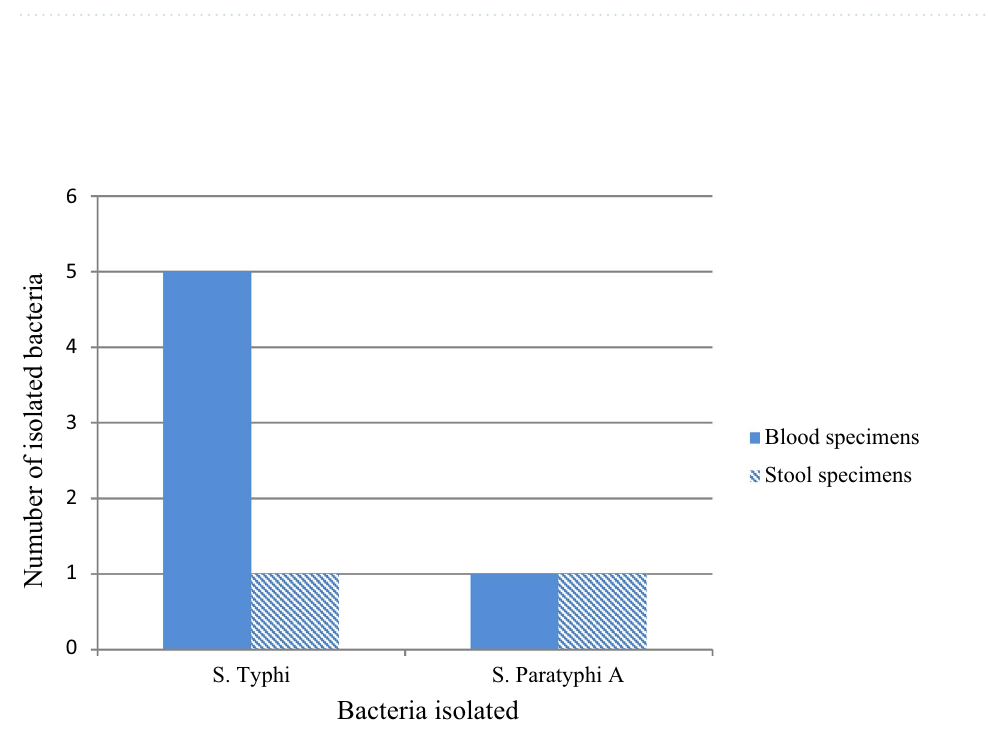
Figure 1. Distribution of Salmonella serovars among different clinical specimens obtained from study participants (n = 150) attending at FHCSH, Bahir Dar, Northwest Ethiopia,